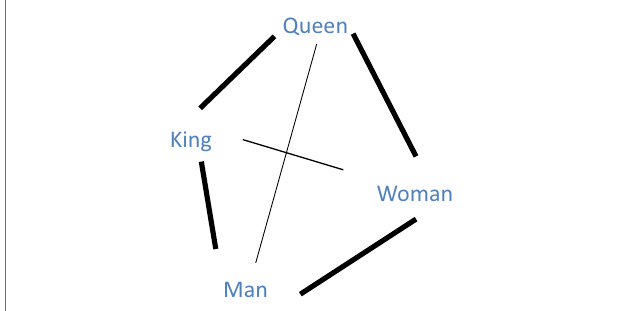
FIGURE 1 | An illustration of a weighted semantic network with four words. Each node represents a word. Each edge is the link between two words that represents the semantic association between those words. The edge weight denotes the semantic similarity between the two linked nodes, which is represented by the thickness of the line in the figure. For example, the similarity between “Queen” and “Woman” is greater than the similarity between “Queen” and